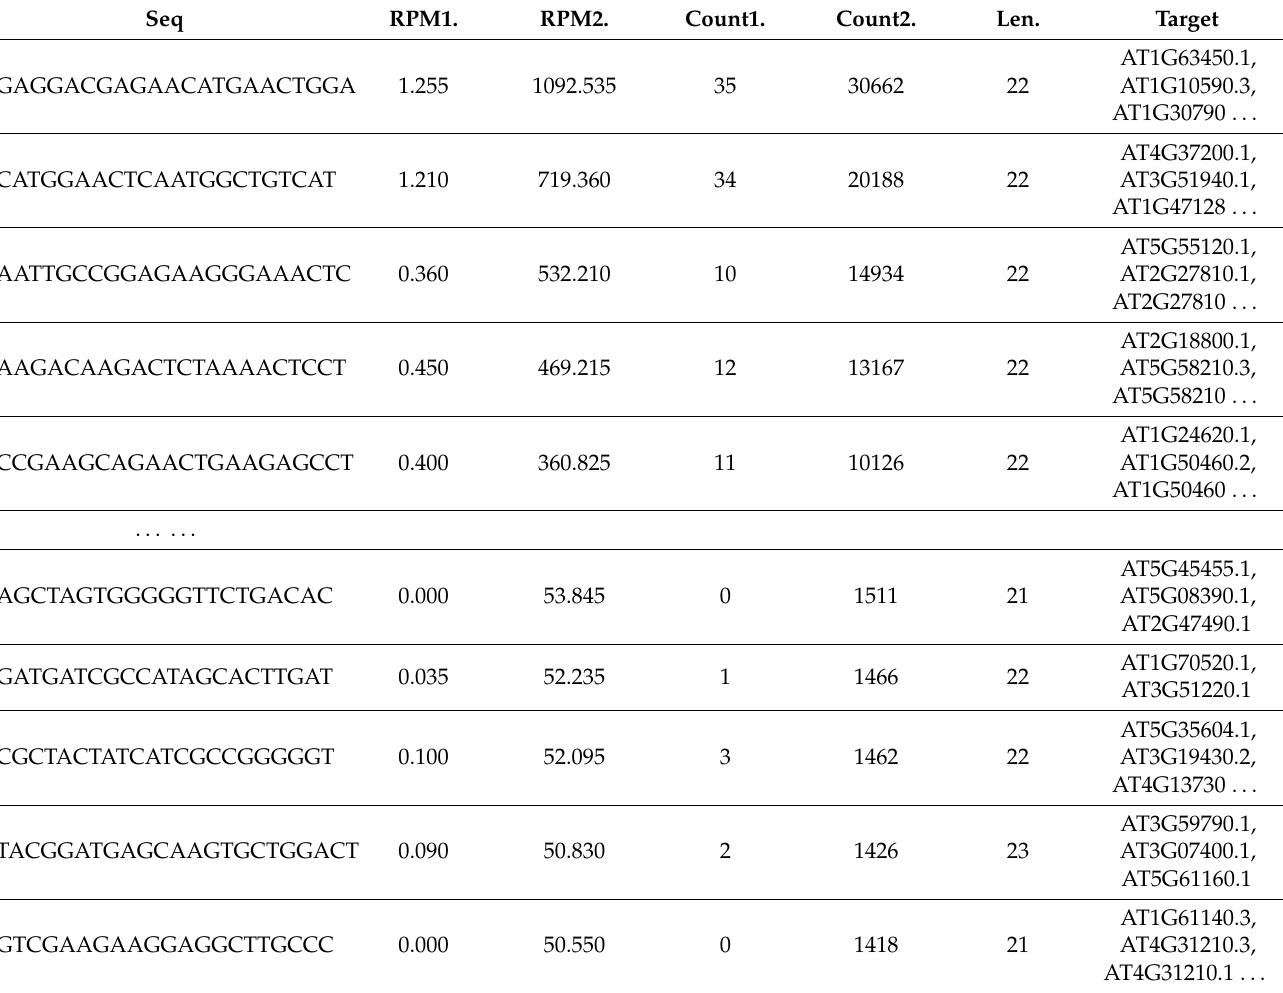
Table 1. 108 sRNA partial displays: RPM values, counts, length, and target genes before and after sRNA infection. RPM1 and RPM2 are the sRNA expressions before and after infection, Count1 and Count2 are the respective sRNA counts before, and after infection, Len is the length of sRNA, and Target is the predicted target